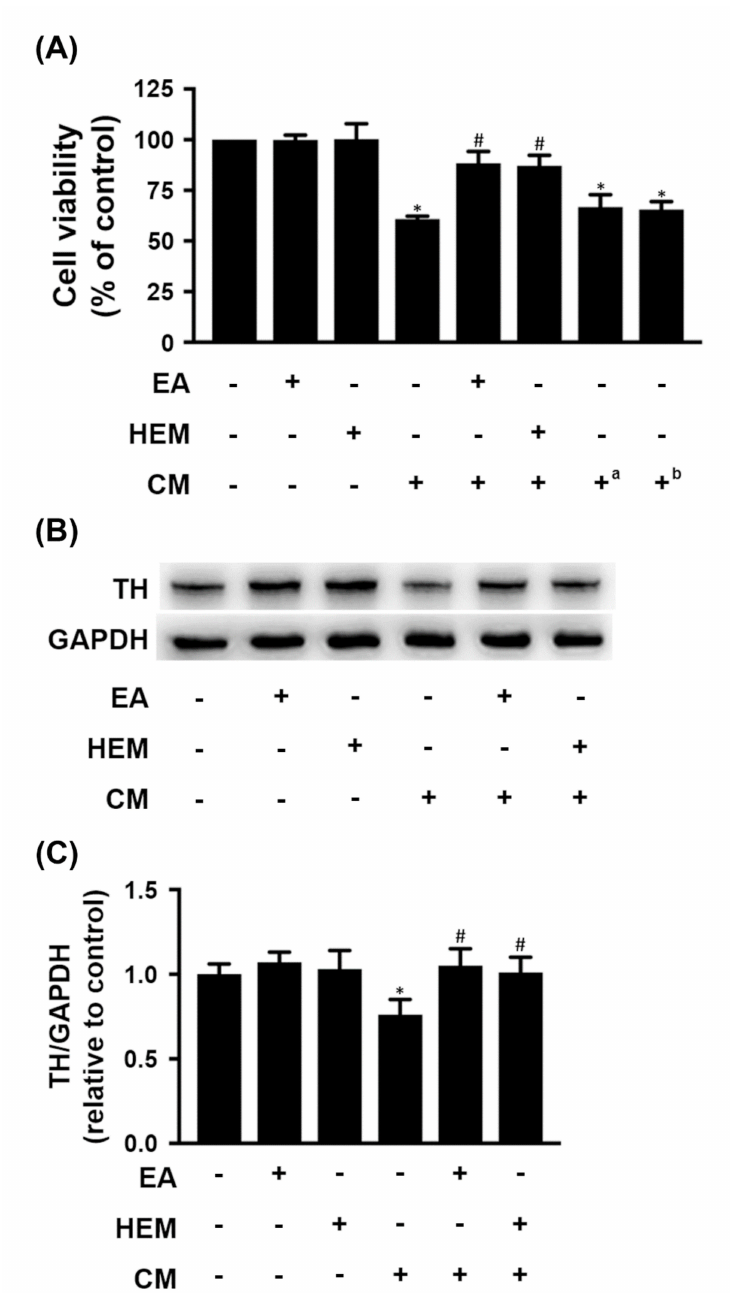
Figure 5. Effects of EA or HEM on microglia-mediated neurotoxicity. N2a cells after incubation in mixed differentiating conditions (0.5% FBS and 1 mM dbcAMP) for 5 days treated with or without EA (10 µ M) or HEM (1 mg/mL) for 48 h or 24 h, half of the medium was removed, and the same amount of conditioned medium was added for 24 h. Conditioned medium (CM) was derived from the culture medium of BV-2 cells with 250 ng/mL LPS treatment for 24 h. ( A ) Cell viability of differentiated N2a cells was examined by MTS assay ( n = 3). a CM contained 10 µ M EA; b CM contained 1 mg/mL HEM. ( B ) The protein levels of TH were detected in N2a cells by western blot ( n = 3). GAPDH was used as a loading control. ( C ) Quantitative densitometry was used to calculate the ratio of TH to GAPDH, which was normalized to the control. The relative density was estimated by NIH ImageJ densitometric analysis. The results are expressed as the mean ± SD. * p < 0.05 compared to the control group. # p < 0.05 compared to the BV-2 conditioned medium treatment